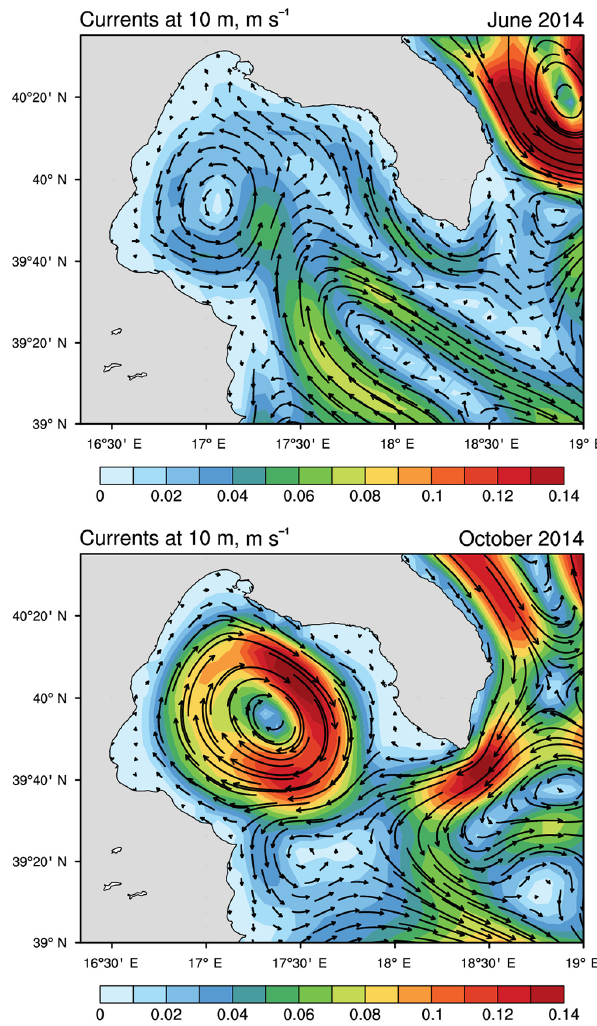
Figure 2. Monthly mean surface currents from reanalysis (Pinardi et al., 2015) in the Gulf of Taranto. Top panel: June 2014. Bottom panel: October 2014. The units are ms − 1 and the color indicates the amplitude.